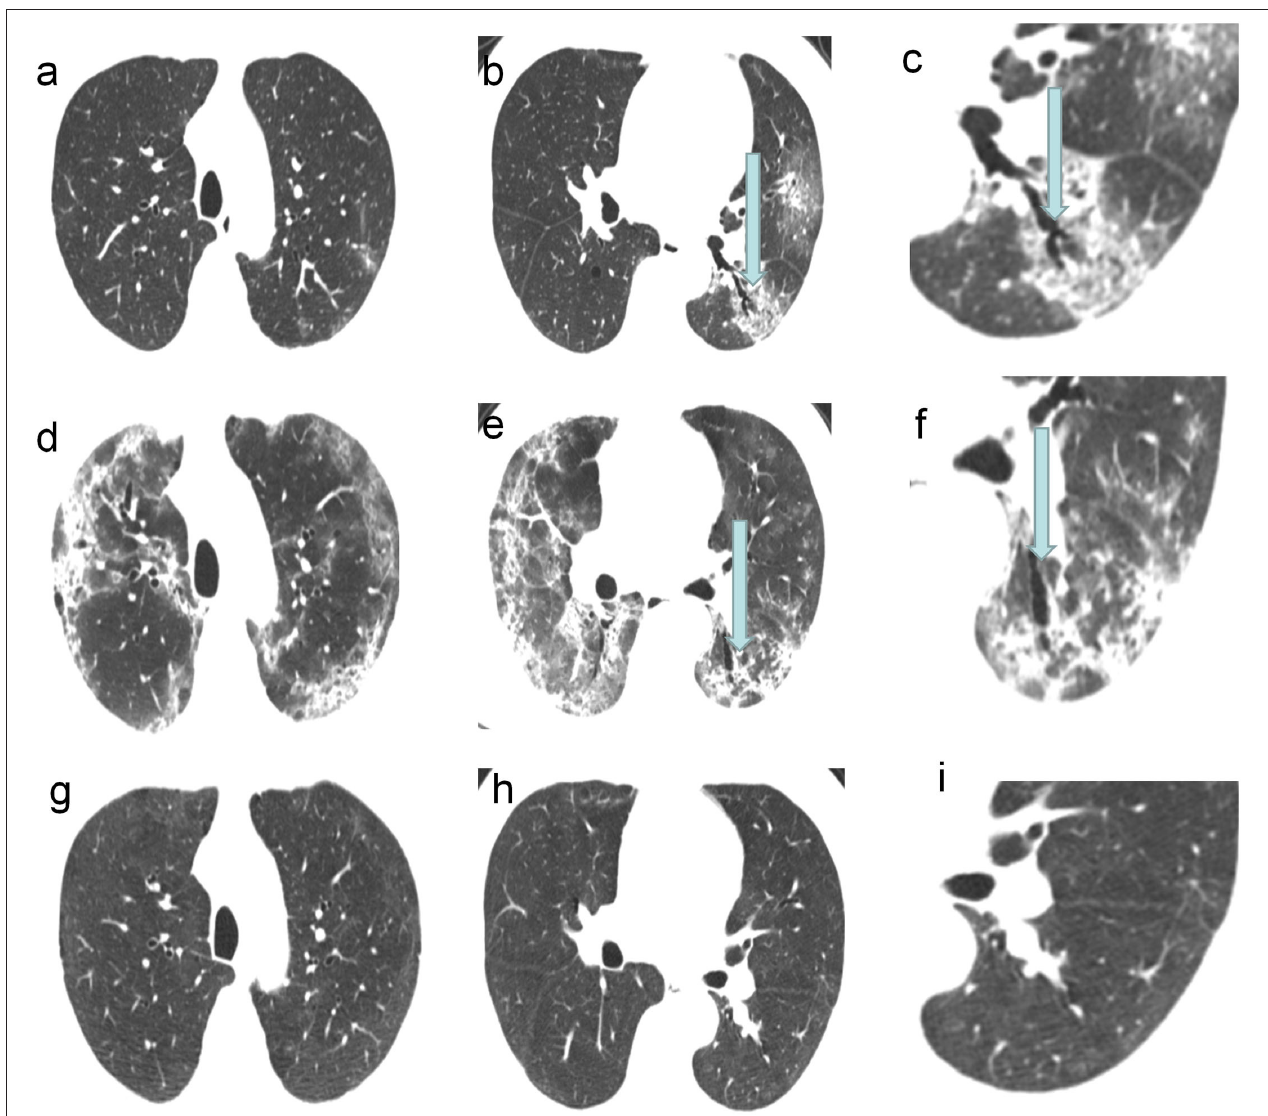
FIGURE 2 | A 62-year-old COVID-19 patients with ARDS: CT scans showed the traction bronchiectasis disappeared completely. (a–c) CT images on the 7th day of the symptom onset showed traction bronchiectasis within area of GGO in the left lower lobe. (d–f) CT images on 19th day of the symptom onset showed the most severe involvement. (g–i) CT images on 133th day of the symptom onset showed the disappearance of traction bronchiectasis in the left lower